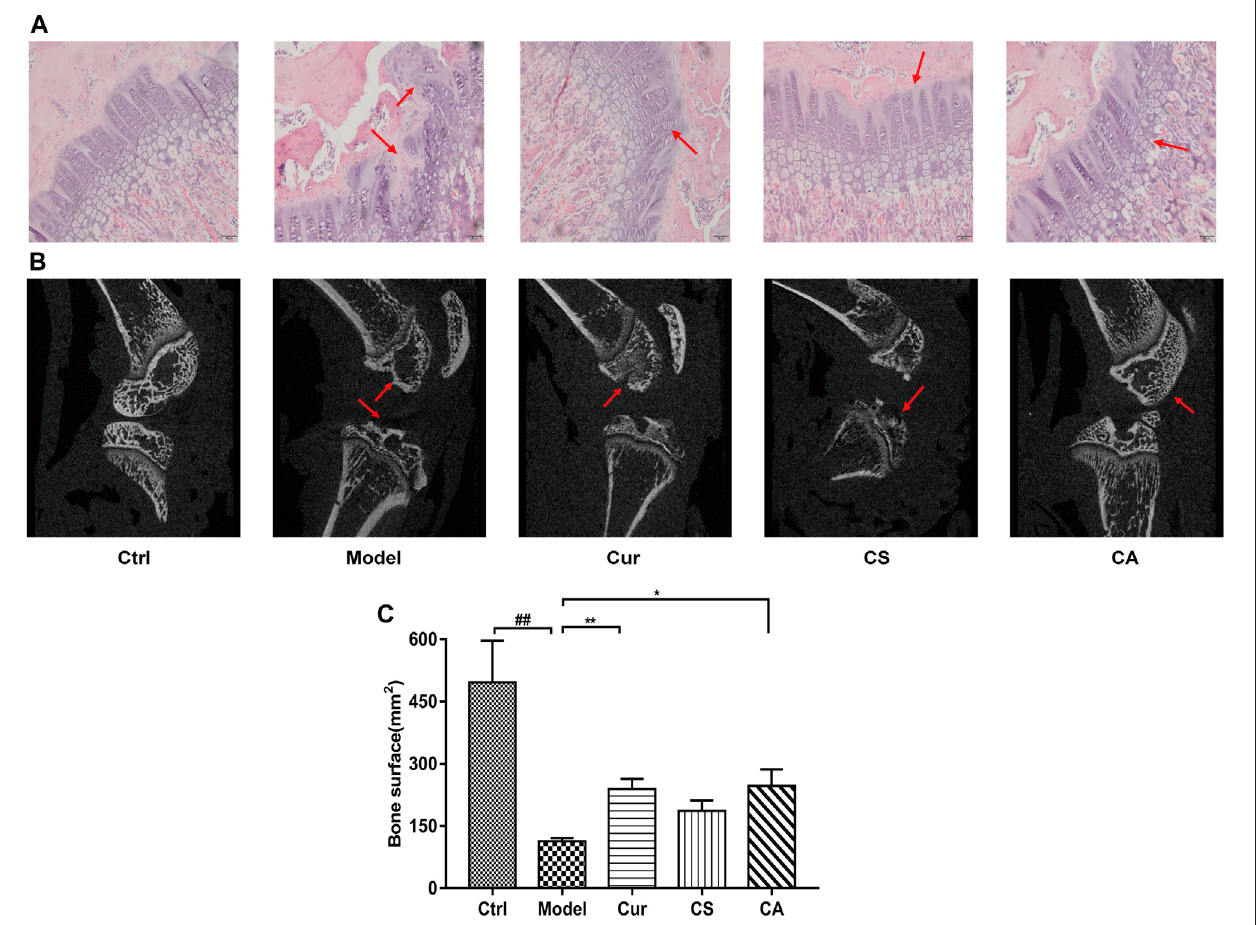
FIGURE2| Protectionofdifferentadministration groupsonkneeosteoarthritisinMIA-induced rats. (A) Representativehistologicalstainingand (B) CTscanningof the knee joint of different groups. Scale bar = 50 μ m. (C) Bone surface. Data are presented as the mean ± SD ( n = 4). ## p < 0.01 vs. Ctrl group; * p < 0.05, ** p < 0.01 vs. model